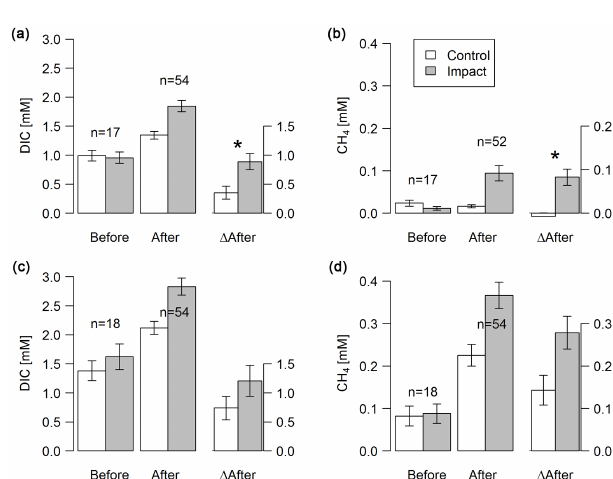
Figure 3. Concentrations of DIC and dissolved CH 4 in ground- water at depth-specific locations (37.5–42.5cm; a–b ) and depth- integrated locations (5–105cm; c–d ) before and after clear-cutting at impact sites, and the respective differences between before and after ( (cid:49) After, shown in the same units). Each bar represents mean values ( ± propagated standard errors) of repeated observations over time. Significant ( p < 0 . 05) effect sizes are marked by an asterisk. Abbreviations: n is the number of